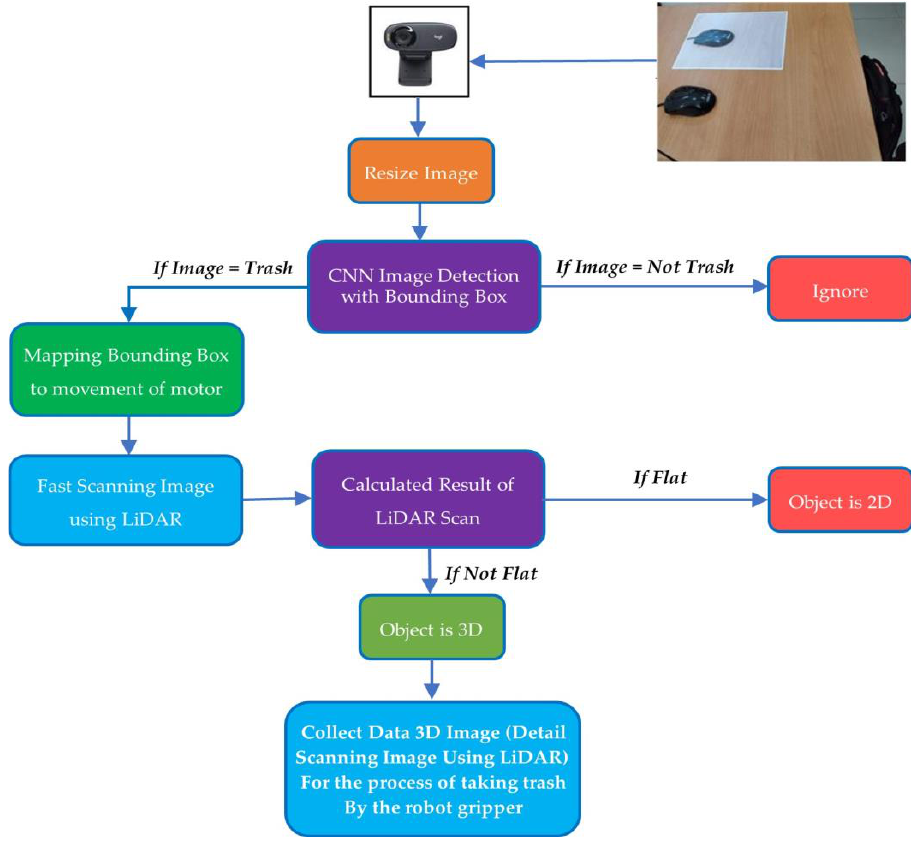
Figure 7. Flowchart of the proposed study.